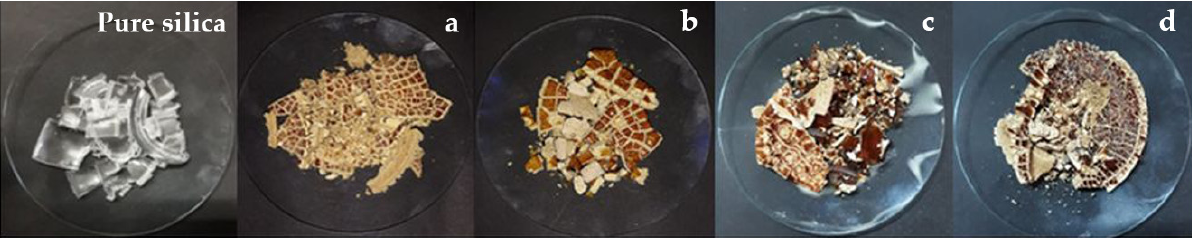
Figure 1. Silica gel obtained with CH 3 COOH: ( a ) 50% orange peel; ( b ) 25% orange peel; ( c ) 50% lemon peel; ( d ) 25% lemon peel.